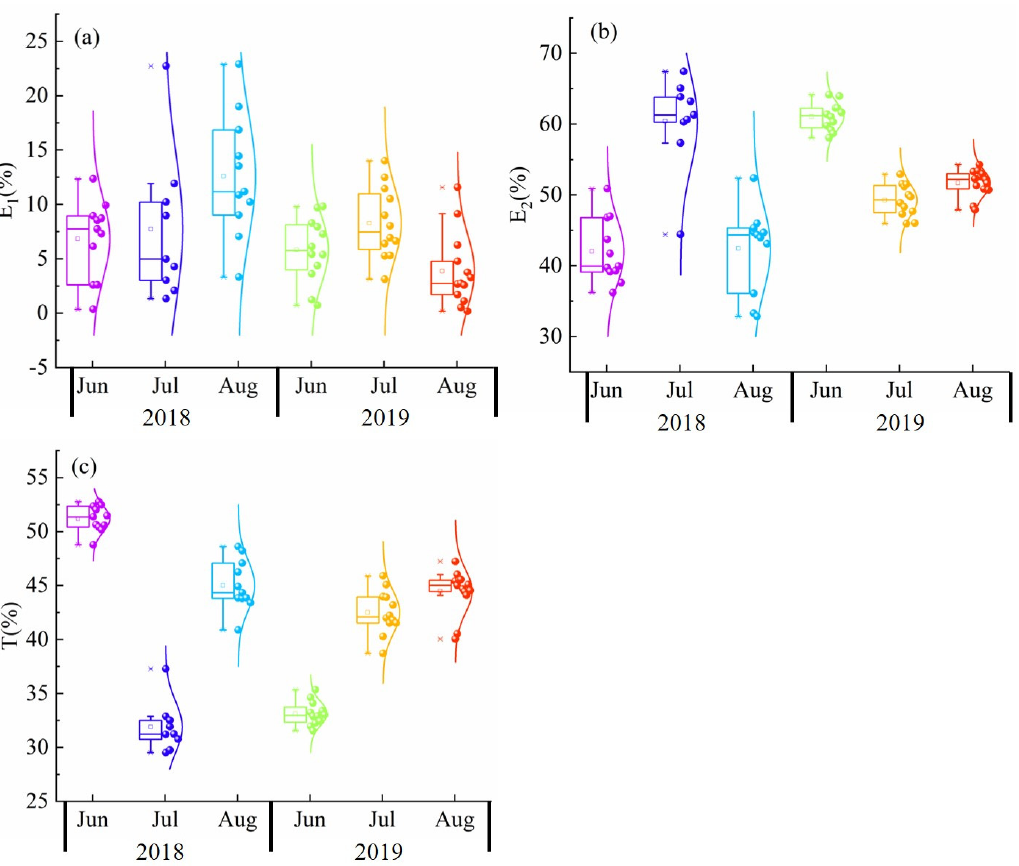
Figure 9. Temporal variation in soil fractionation ratio ( E 1 ) ( a ), soil non-evaporated ratio ( E 2 ) ( b ) and plant transpiration ratio ( T ) ( c ) in summer of 2018 and 2019.